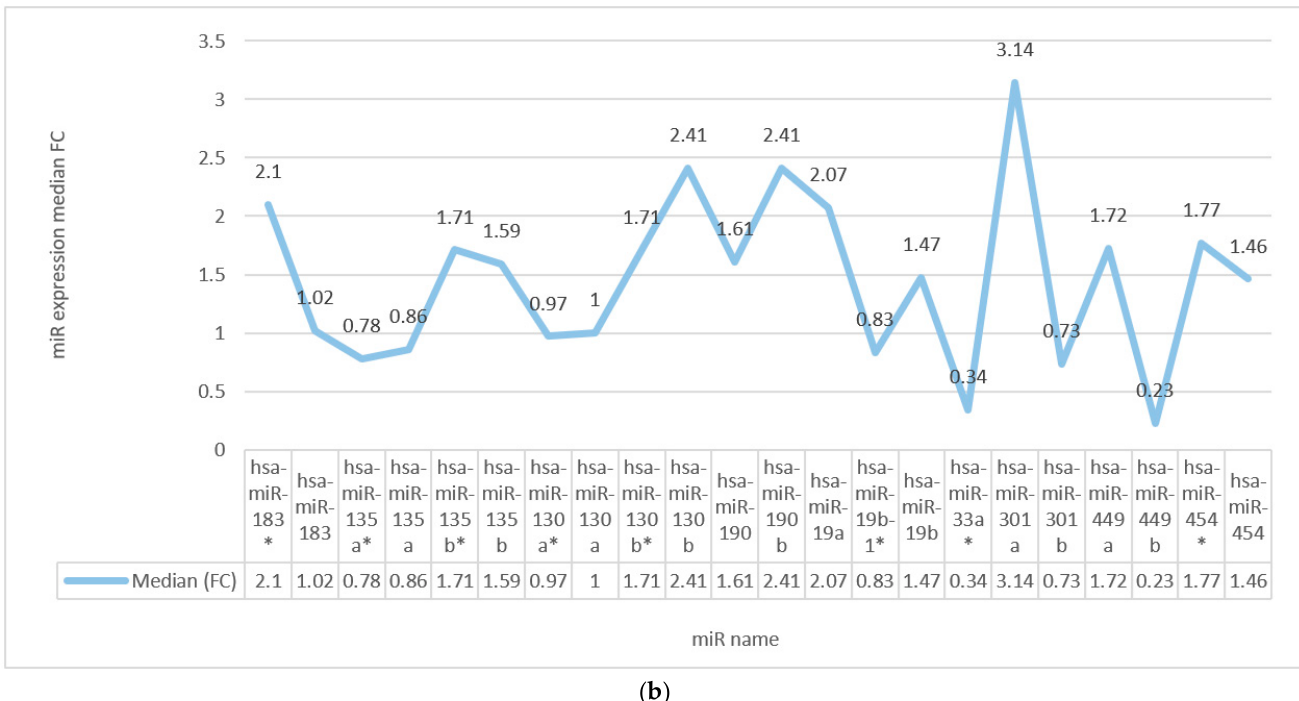
Figure 3. ( a ) Distribution of expression levels of CSMD1 miRNA targets in ESCC cases. Red bars indicate miR overexpression (FC ≥ 2.00), green bars indicate miR underexpression (FC ≤ 0.50), and yellow bars indicate miR expression in the normal range (FC 0.49-1.99). ( b ) CSMD1 target miR expression median fold change (FC) across 22 miRs, with the miRs shown across the horizontal axis.